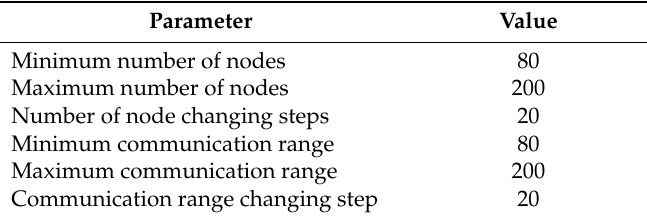
Table 1. Experimental parameter